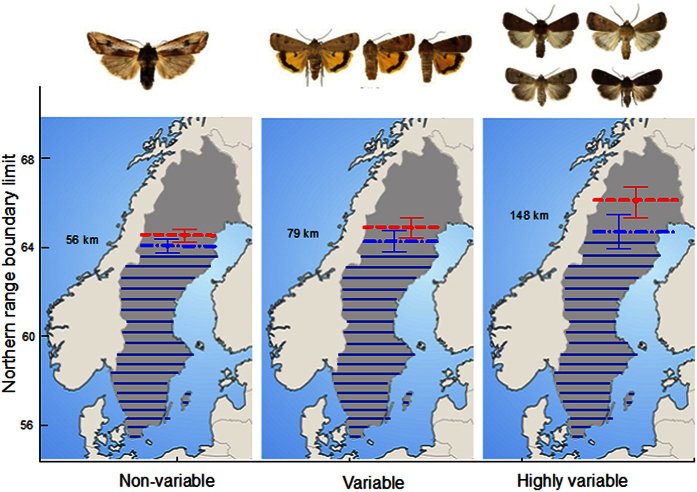
Northern distribution range boundaries in Sweden in 1973 and 2014 for species of moths with non-variable, variable, or highly variable colour patterns.Least-squares means ± SE (obtained from a MIXED model ANOVA) for 1973 (blue, dash dot) and 2014 (red, short dash). Result for 1973 (effect of family: F2,208 = 0.34, P = 0.56; effect of colour pattern: F2,400 = 0.49, P = 0.61). Result for 2014 (family: F1,201 = 0.88, P = 0.348; colour pattern: F2,396 = 2.41, P = 0.091). Numbers indicate mean expansion between 1973 and 2014. The map was generated in Adobe Photoshop CS5 Extended, version 12.0.4 × 32, http://www.adobe.com/se/products/photoshop.html. The image was modified from a base map available under non-restrictive creative commons license obtained from https://commons.wikimedia.org/wiki/File:Scandinavia-template.png. Photos (by Vladimir S. Kononenko) show (from left to right) Xylena vetusta, Noctua orbona, and Xestia xanthographa representing each category of colour pattern variation.